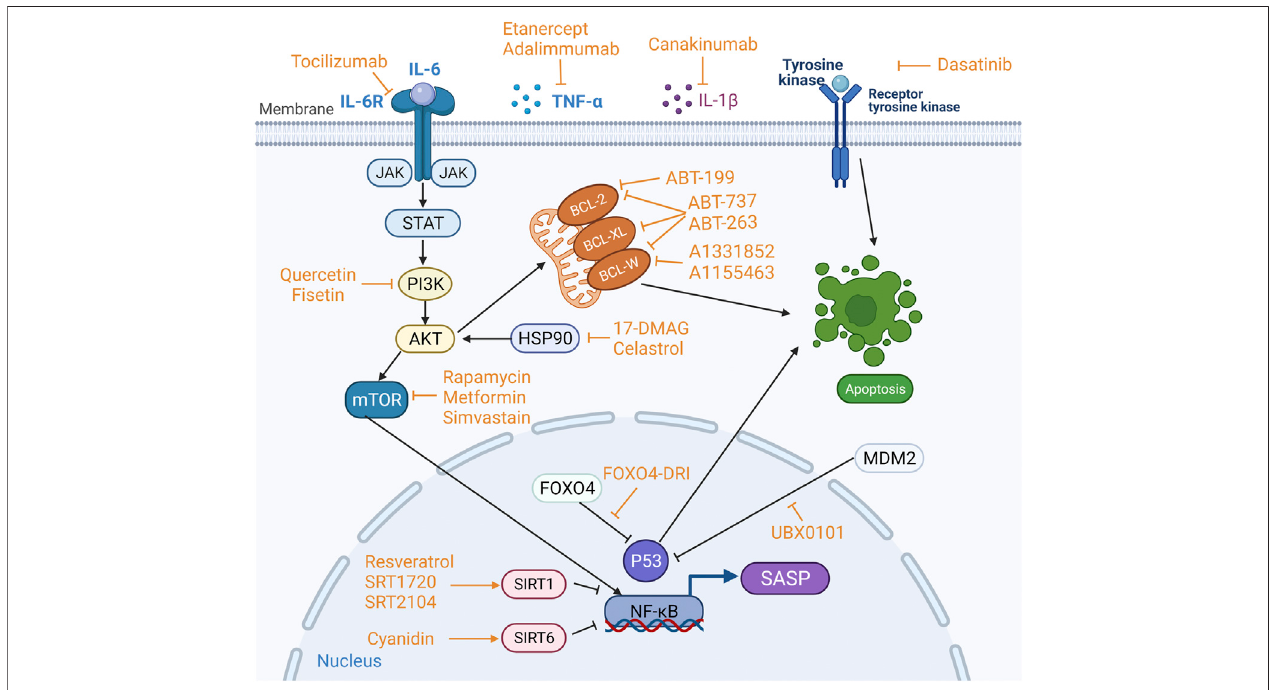
FIGURE 3 | Targets of sirtuin-activating compounds (STACs), senolytics and senomorphics. Anti-apoptotic pathways and pro-survival pathways are upregulated in senescent cells (SnCs), and the key proteins involved in the anti-apoptotic pathway are BCL-2, BCL-W and BCL-XL in the BCL-2 protein family, and p53 phosphatidylinositol 3-kinase(PI3K),AKT, FOXO4,tyrosine kinase andheatshock protein 90(HSP90). Differentanti-cellularsenescence agents act ondifferent targets. STACs resistagingmainlybyactivating sirtuins. Senolytics target anti-apoptoticpathwaystoinduceapoptosis inSnCs. SenomophicssuppressSASPfunctionby inhibiting the production of SASP or neutralizing a speci fi c SASP component, thereby inhibiting cellular senescence.